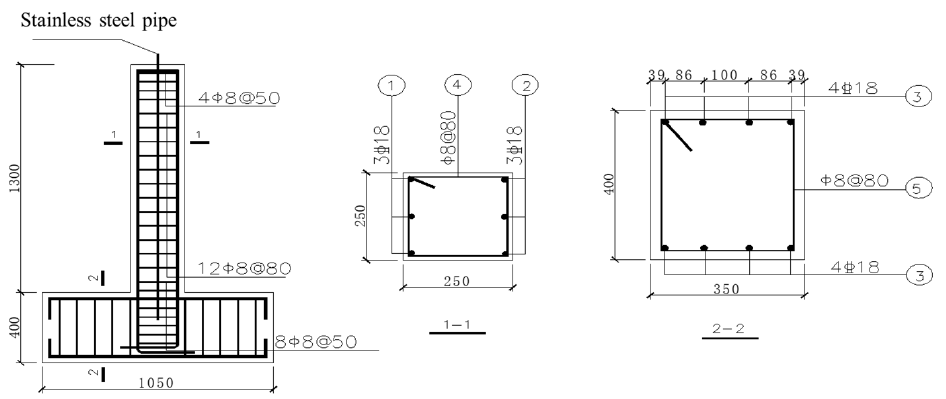
Figure 1. Geometric size of column and arrangement of bars.